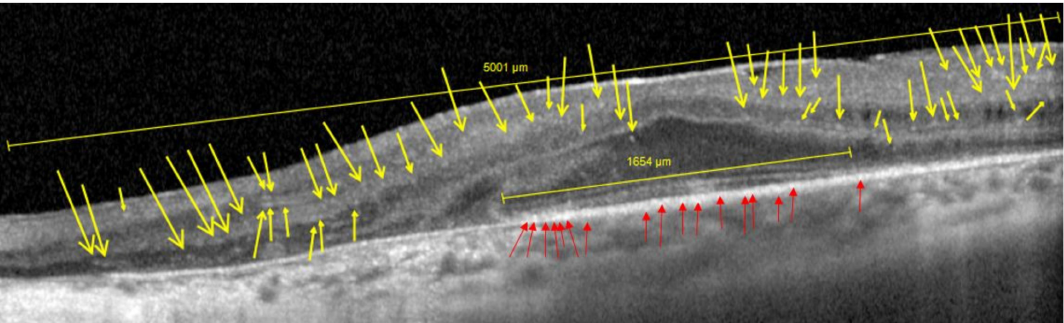
Figure 2. An example of optical coherence tomography (OCT) measurement, using the macular thickness image-protocol (right eye), of an RP patient. Except for the average number of HRF-ER (yellow-colored arrows), we calculated those of the HRF-ONL (red-colored arrows), as well as the length of the EZ (horizontal line, yellow-colored, on the